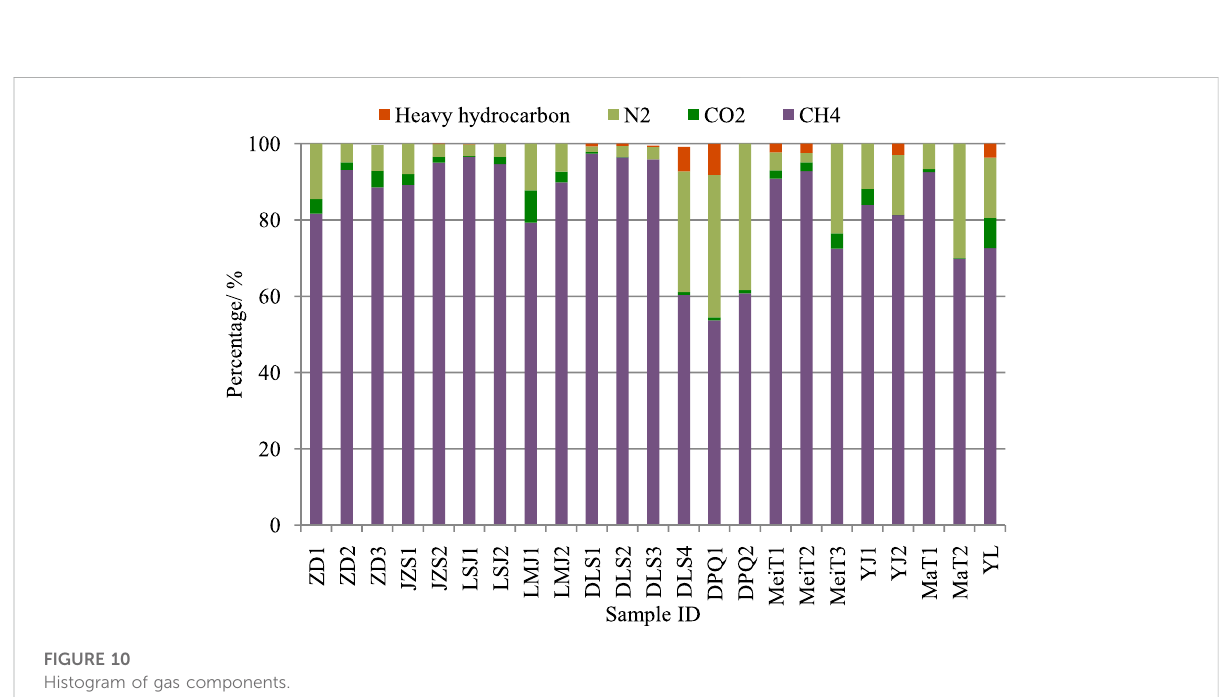
FIGURE 10 Histogram of gas